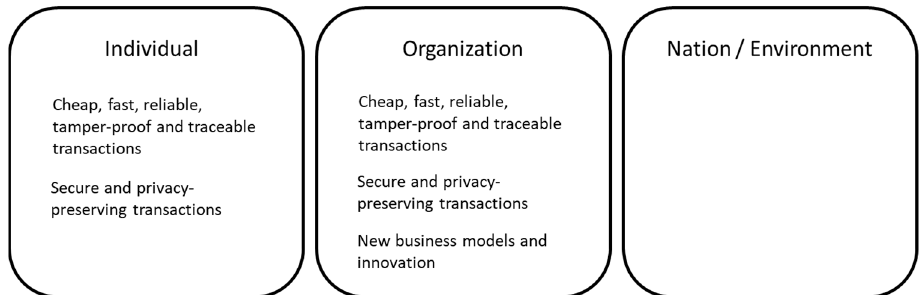
Figure 5. Bitcoin as an alternative payment system.